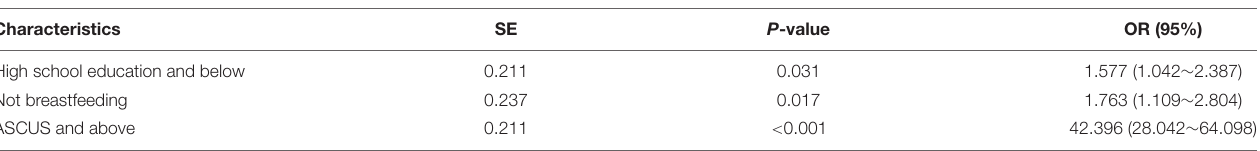
TABLE 13 | Multivariate analysis of risk factors for cervical cancer and precancerous lesions.